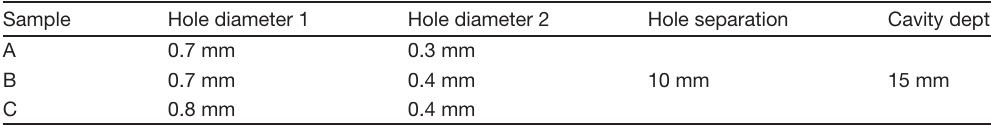
Table 1. Parameters of the samples for preliminary